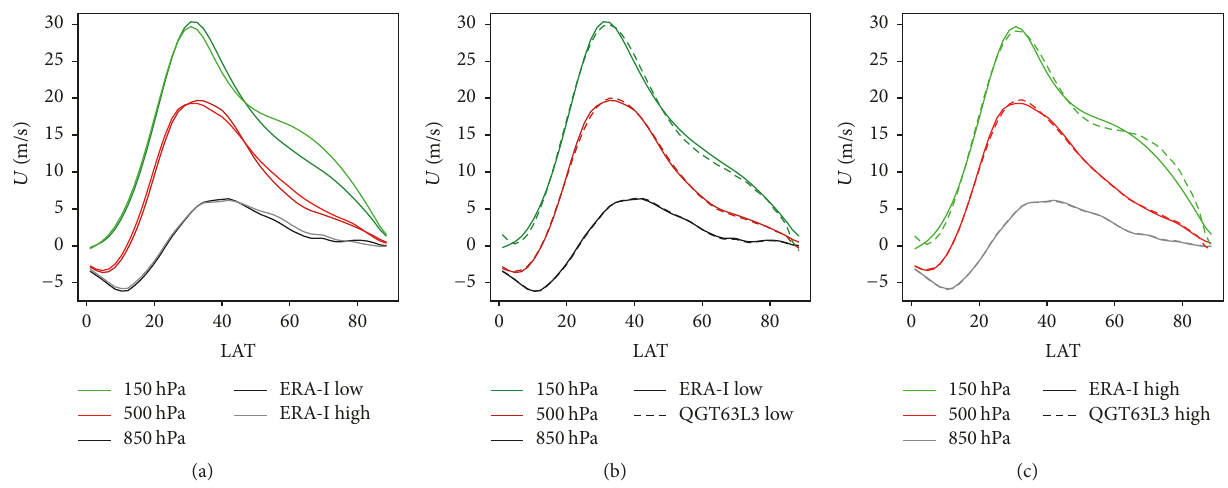
Figure 2: (a) The target (observed) time-mean zonal wind profiles (m/s) for the three model levels. The dark and light lines correspond to low and high Arctic sea-ice-cover conditions, respectively; the green, red, and black/grey color of lines refers to the upper, middle, and lower levels, correspondingly. (b) The target (observed, solid lines) and simulated (dashed lines) time-mean zonal wind profiles (m/s) for the three model levels for low Arctic sea-ice-cover conditions. (c) The same as in (b) but for high Arctic sea-ice-cover